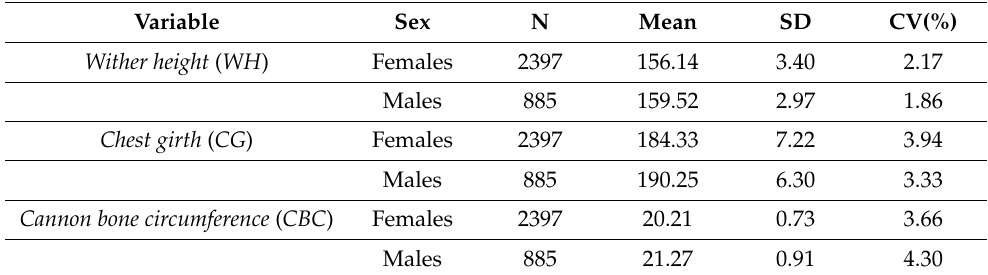
Table 7. Summary statistics for the three considered body measurements